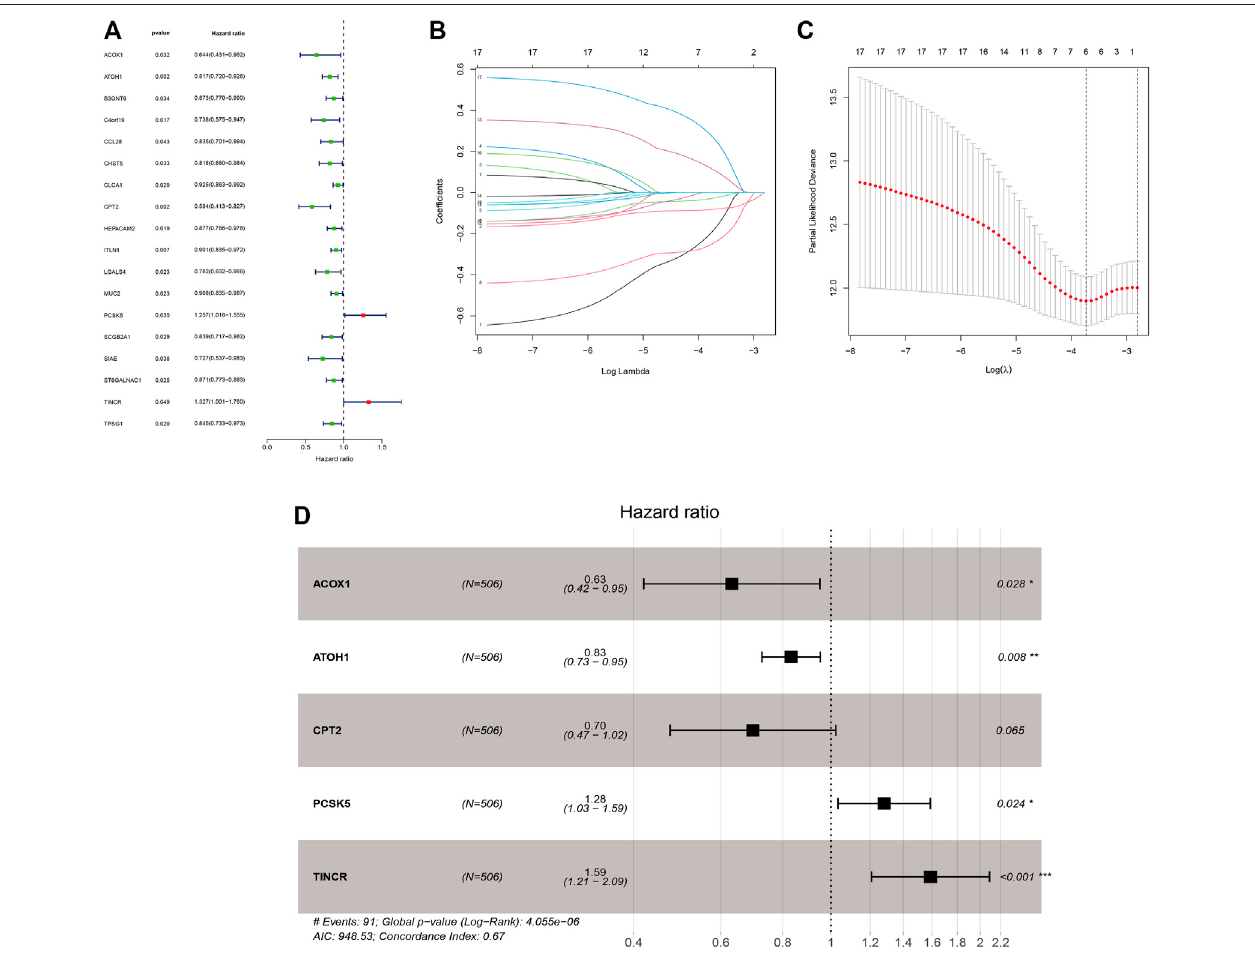
FIGURE 5 | The construction of the fi ve-GMRHG prognostic signature. (A ): 18 prognosis-associated GMRHGs screened by univariate Cox regression analysis. (B,C) : The LASSO regression analysis for the prognosis-associated GMRHGs. (D) : Five prognosis-associated GMRHGs screened by multivariate Cox regression